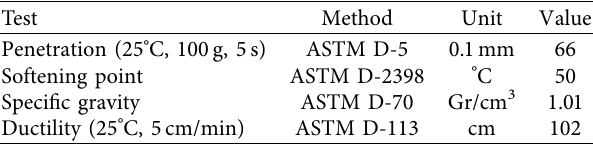
Table 2: Specifications of asphalt binder (AC 60–70).